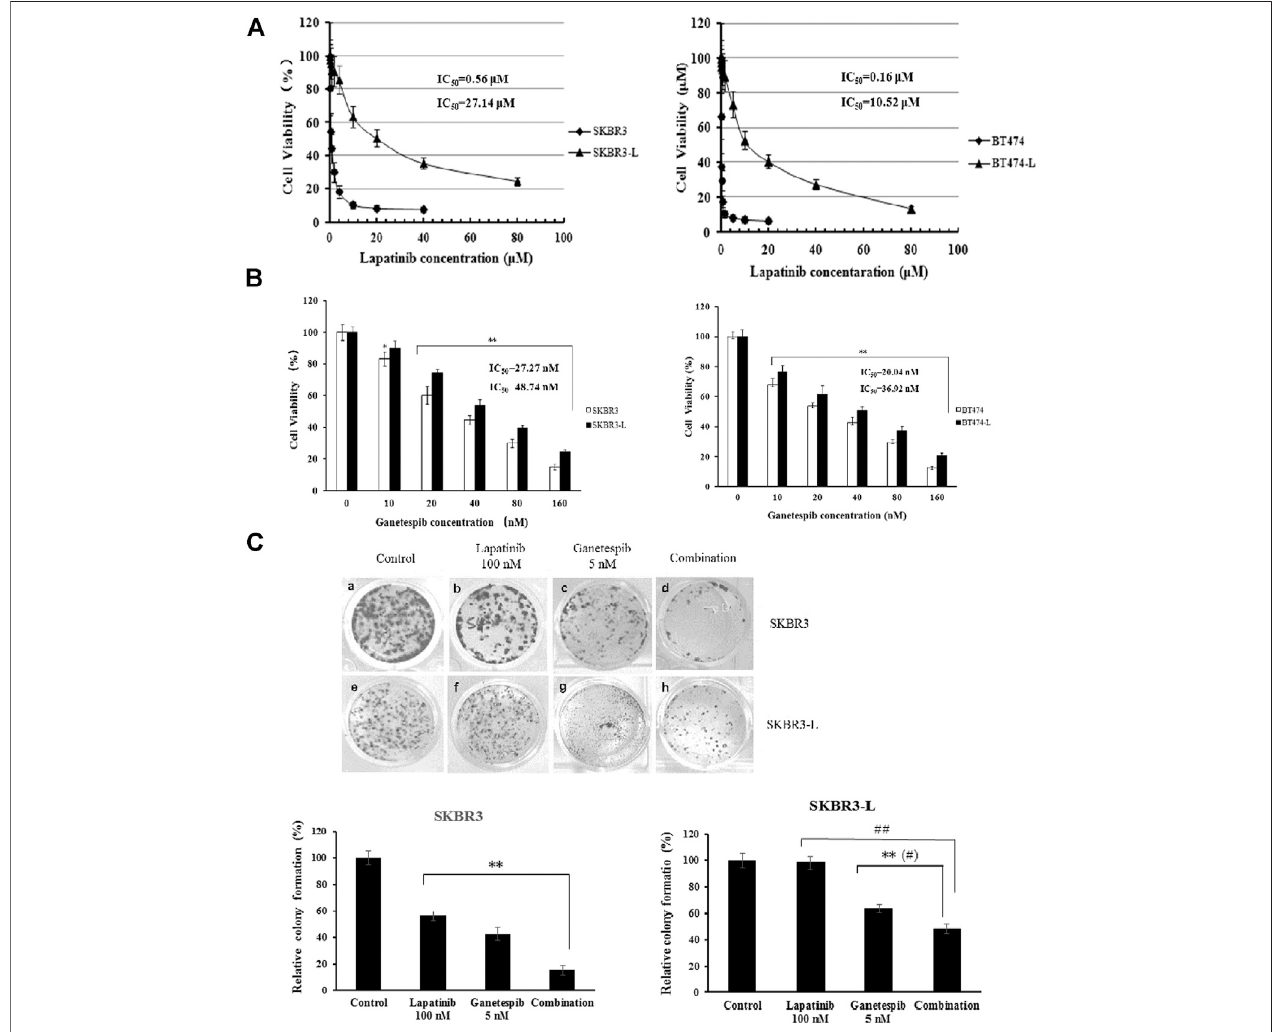
FIGURE 1 | Antiproliferative activity of ganetespib in lapatinib-sensitive and -resistant HER2 + breast cancer. (A) SKBR3, SKBR3-L, BT474, and BT474-L were treatedfor48 hinthepresenceoflapatiniborDMSOvehicletocon fi rmthelapatinib-resistanceofSKBR3-LandBT474-Lbreastcancercelllines. (B) SKBR3,SKBR3-L, BT474, and BT474-L were treated for 48 h with ganetespib or DMSO vehicle. Cell viability wasmeasured withMTS and isexpressed asa percentage ofvehicle-treated control. Results are presented as means ± SD of three independent experiments. * p < 0.05: signi fi cant difference from control by ANOVA; ** p < 0.01: very signi fi cant difference from control by ANOVA. (C) Effect of ganetespib and lapatinib on colony formation of SKBR3 and SKBR3-L cells. ** p < 0.01 vs. control, # p < 0.05 and ## p < 0.01 vs . combination administration by ANOVA.